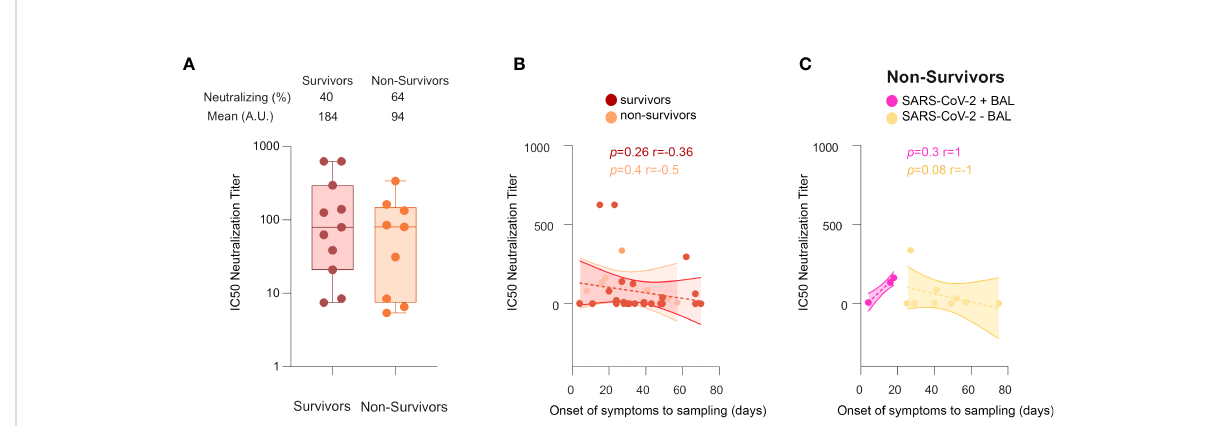
FIGURE 7 Neutralization activities in COVID-19+ survivors vs non-survivors. (A) Comparison between IC50 neutralization titers between survivors and non-survivors. (B) Cross-sectional representation of neutralizing antibodies in survivors vs non-survivors, shown as correlation between IC50 neutralization titters and time from symptom onset to sampling date in survivors and non-survivors. (C) Cross-sectional representation of neutralizing antibodies in non-survivors, shown as correlation between IC50 neutralization titters and time from symptom onset to sampling date, in SARS-CoV-2+ BAL and SARS-CoV-2 − BAL individuals. All correlations were calculated using Spearman ’ s test. p -Values were calculated by using Wilcoxon test. BAL: bronchoalveolar